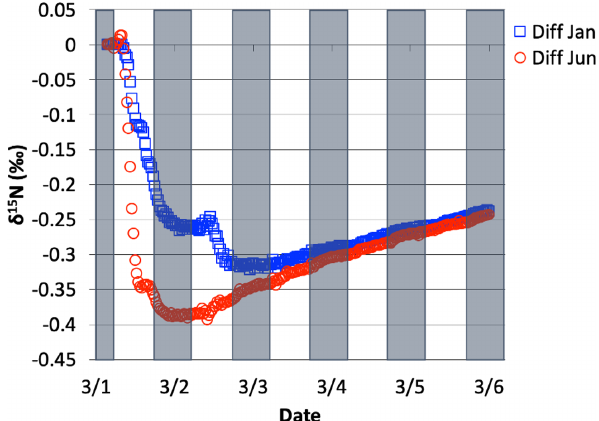
Figure 12. The difference in δ 15 N(HNO 3 ) values when NO 3 + VOC → HNO 3 reactions are included and excluded, for 1 March simulation, relative to 1 June simulation and 1 Jan simulation. The 5d simulation was under the conditions list in Table